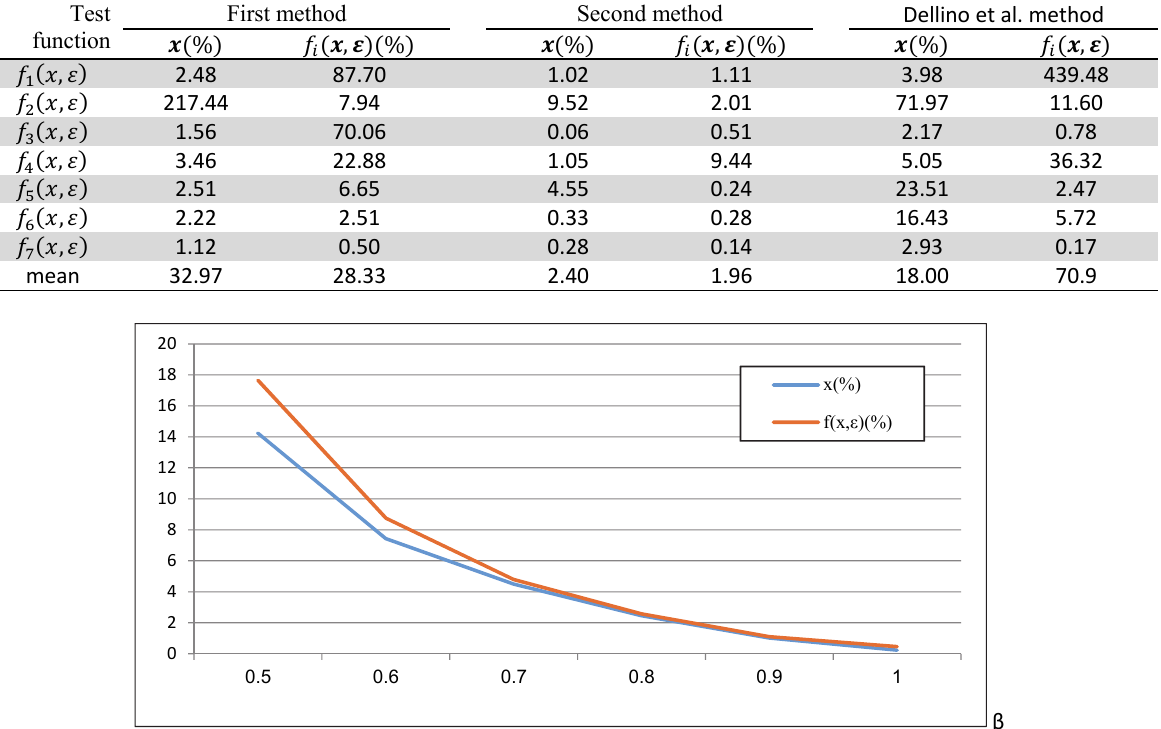
Fig. 1 . The relative deviations of the objective function and robust solution for different values of β for